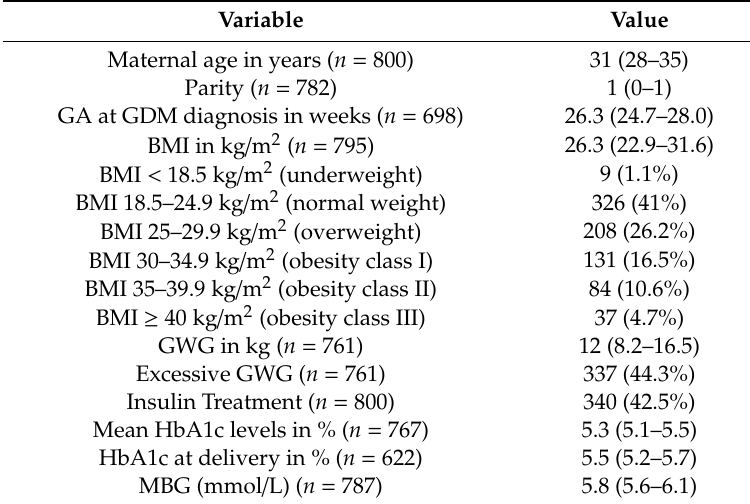
Table 1. Descriptive parameters of the entire cohort ( n = 800).